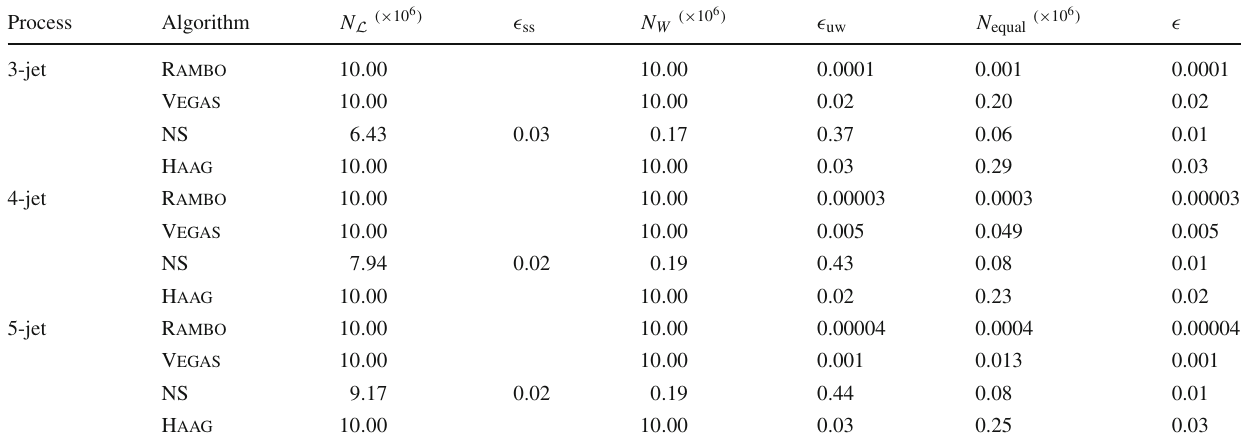
Table 5 Comparison of the four algorithms for the three processes in terms of size of event samples produces. N L gives the number of matrix element evaluations, N W the number of weighted events, N W , eff the effective number of weighted events and N equal the derived number